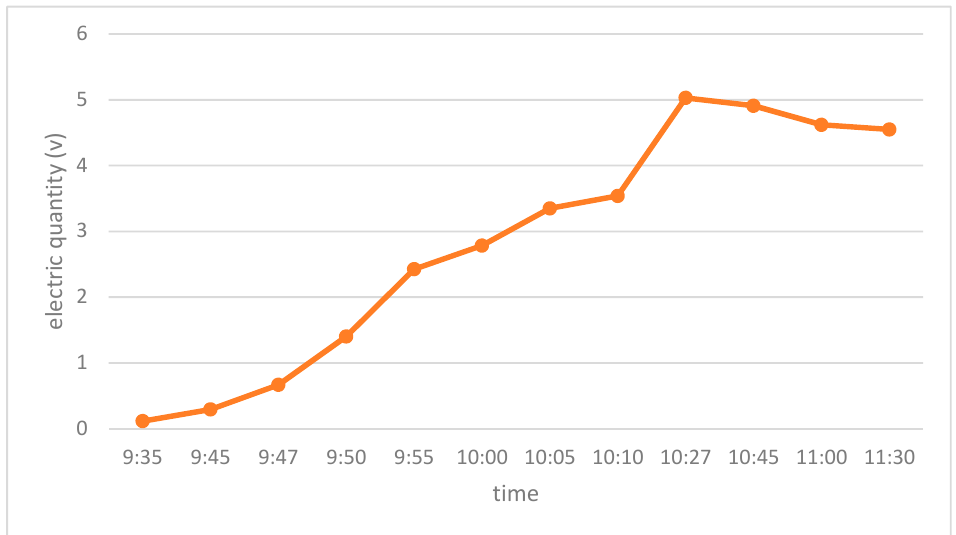
Figure 15. The charge curve of the photovoltaic subtle energy-powered RFID tag adopted in the proposed system. This experiment was conducted in a rainy day. The luminance ranged between 1825 lux and 13,000 lux during the test period of time. The RFID tag was fully charged at 10:27, and the whole charging process took around 50 min.